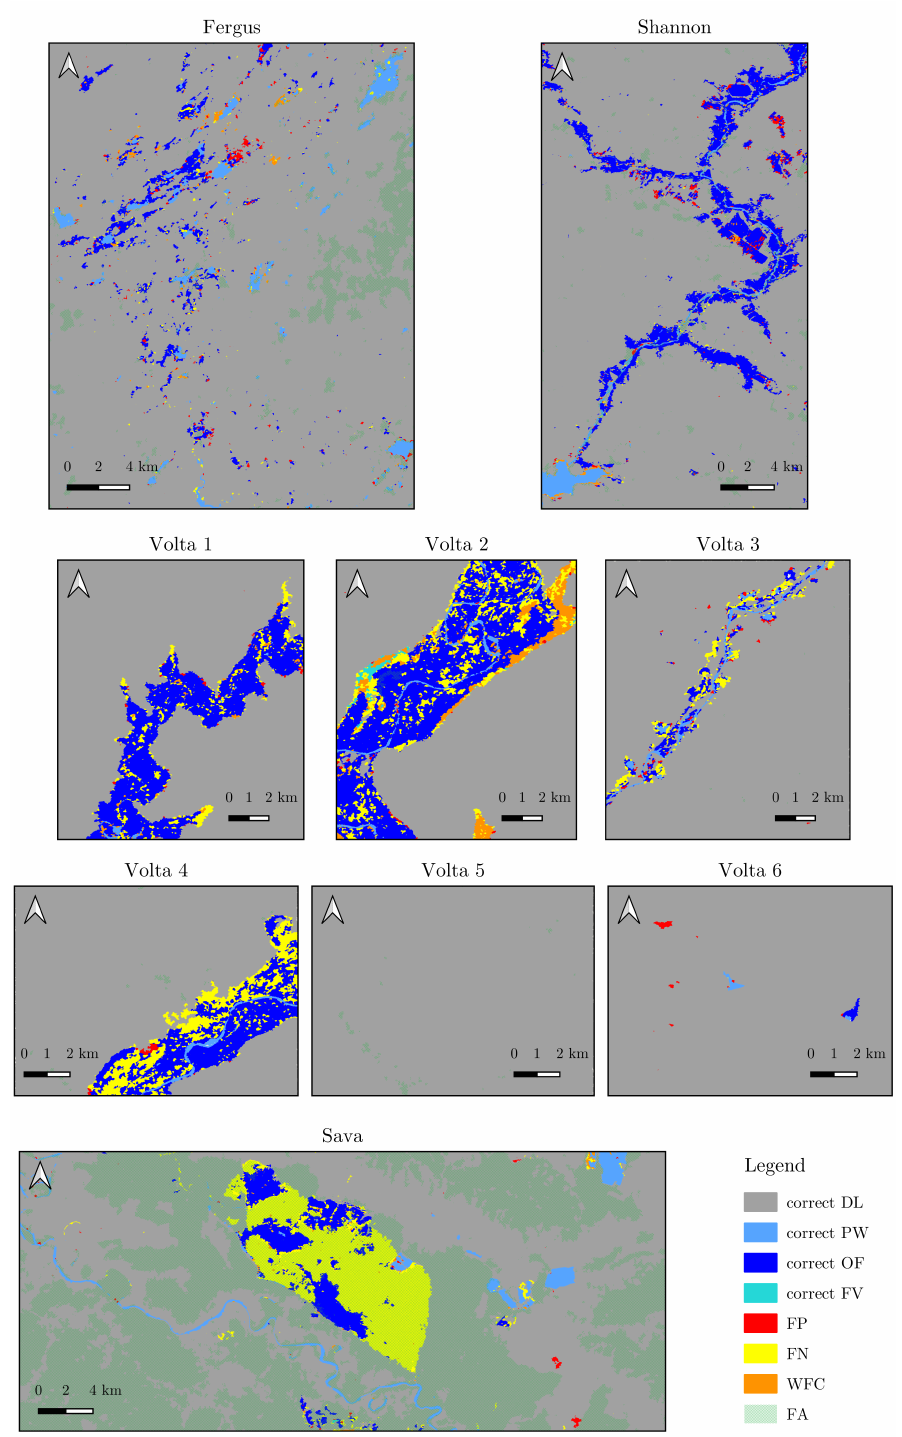
Figure 6. Contingency maps of the final classification all ROIs. These maps discriminate between correctly classified dry land (DL), permanent water (PW), open flooding (OF), and flooded vegetation (FV), false positives (FP), false negatives (FN), within flood confusion (WFC), and forested areas